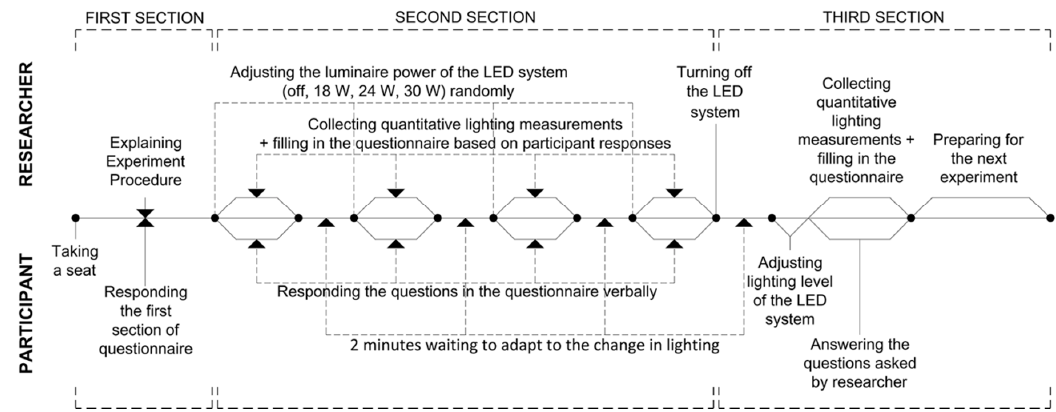
Figure 3. Experimental flow in the test office room.